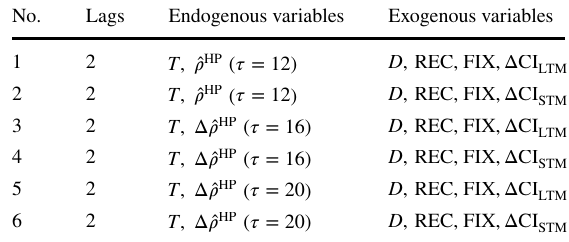
Table 4 PVAR model specifications. Source : Own